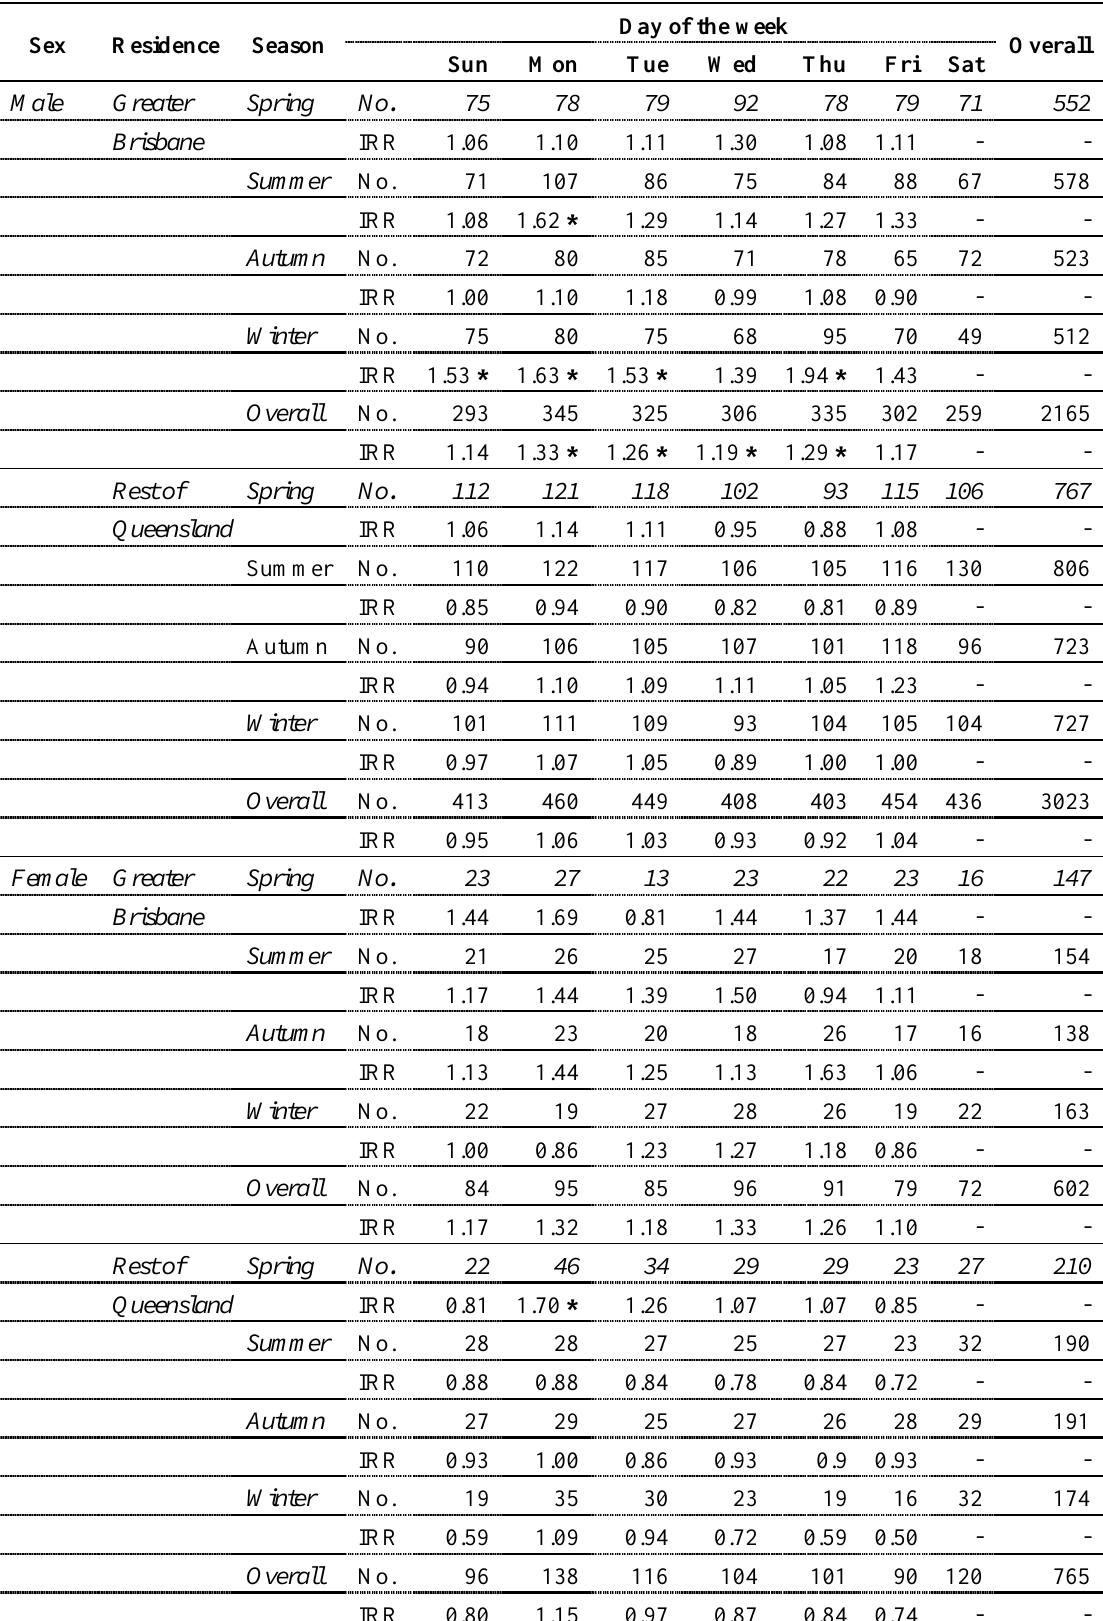
Table 1. Number and Incidence risk ratios (IRR # ) of suicide by day of the week, season of the year, sex and residence of deceased, Queensland, 1996–2007. Sex Residence Greater